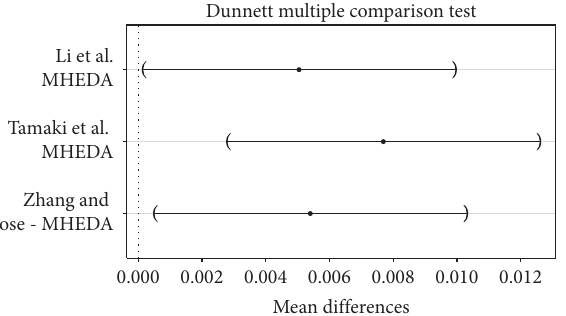
Figure 17: Dunnett test for the MHSP.